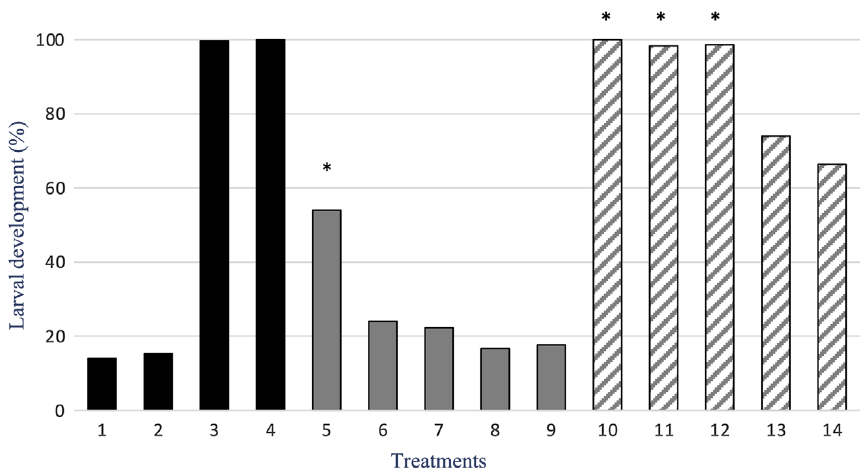
Figure 3. Percentage (%) of inhibition of gastrointestinal strongyle larval development by fi ve concentrations of Glycyrrhiza glabra aqueous extract and of glycyrrhetinic acid. Columns: 1: Untreated, 2: DMSO, 3: Thiabendazole, 4: Thiabendazole plus DMSO, 5: 30 mg/mL, 6: 10 mg/mL, 7: 5 mg/mL, 8: 1 mg/mL, 9: 0.5 mg/mL of G. glabra , and 10: 30 mg/mL, 11: 10 mg/mL, 12: 5 mg/mL, 13: 1 mg/mL, 14: 0.5 mg/mL of glycyrrhetinic acid.